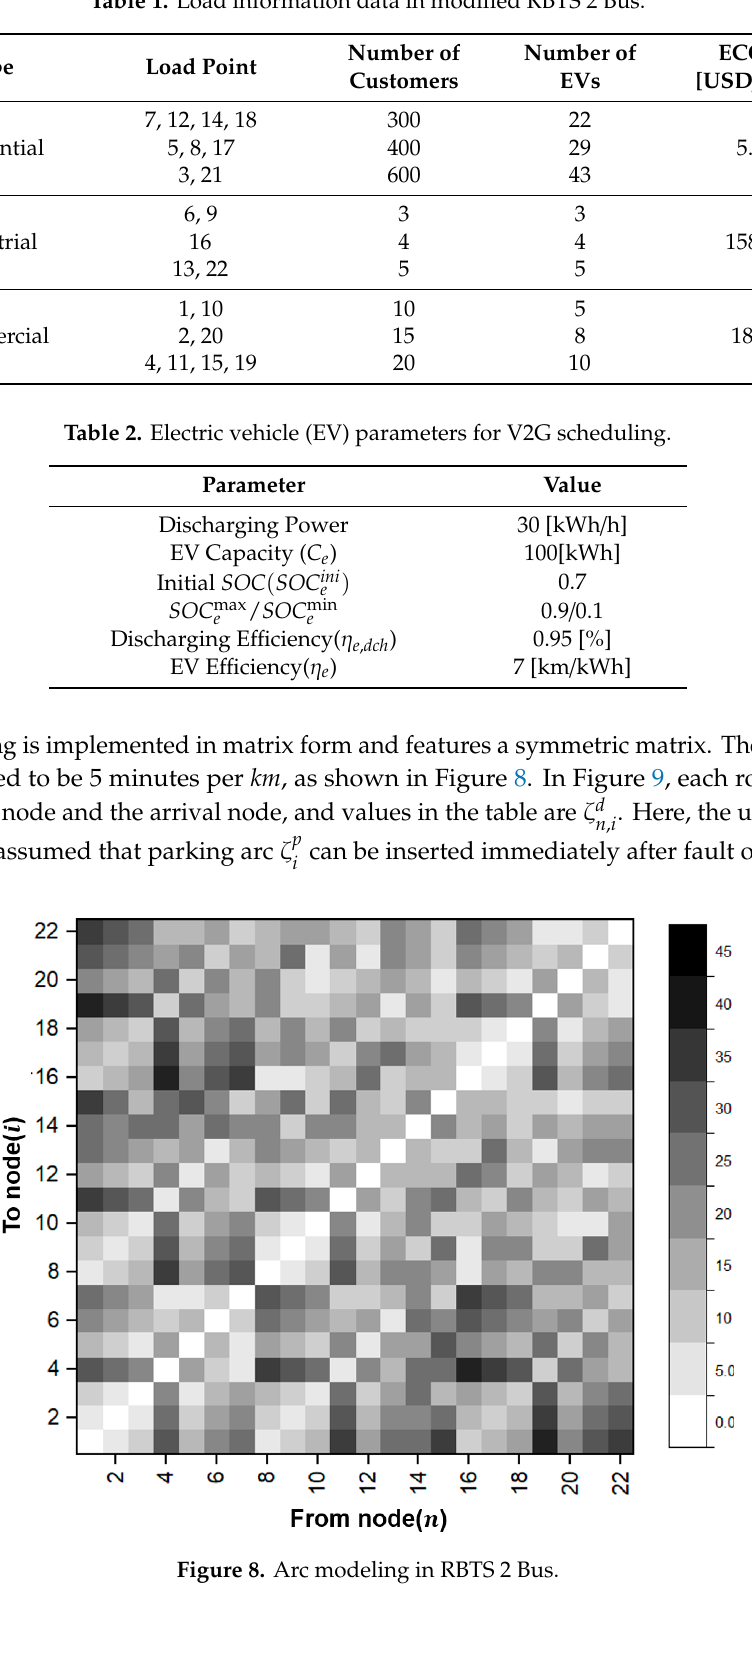
Table 1. Load information data in modified RBTS 2 Bus.